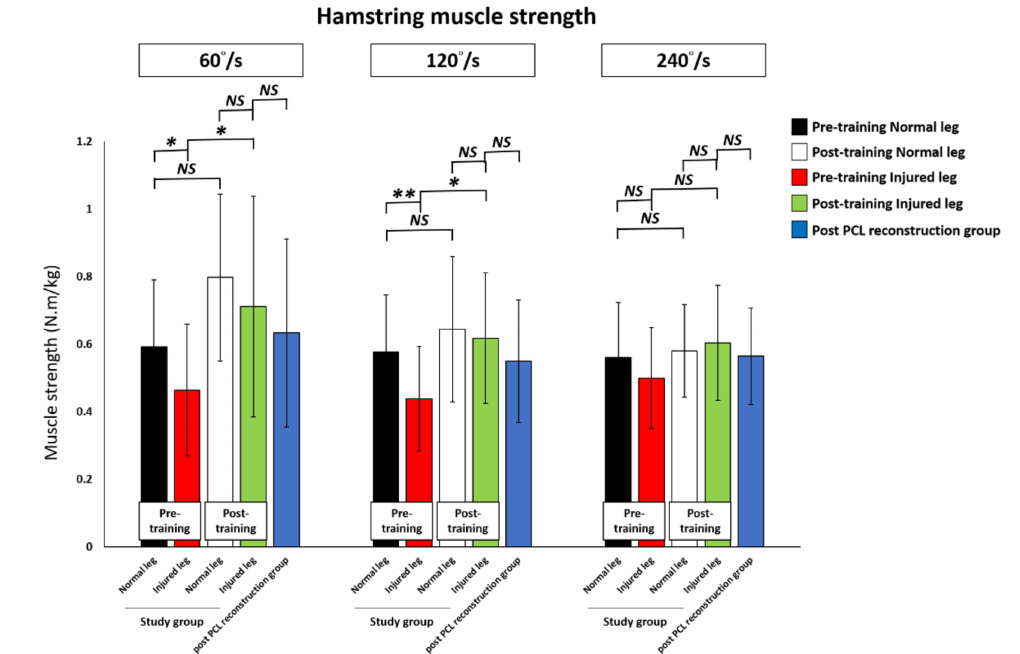
Figure 6. Comparison of the quadriceps muscle strength change at pre-training, at post-training, and in the post-PCL reconstruction group. PCL: Posterior cruciate ligament. * p < 0.05 indicates statistical significance. ** p < 0.01 indicates high statistical significance between two groups. NS: No significant difference between two